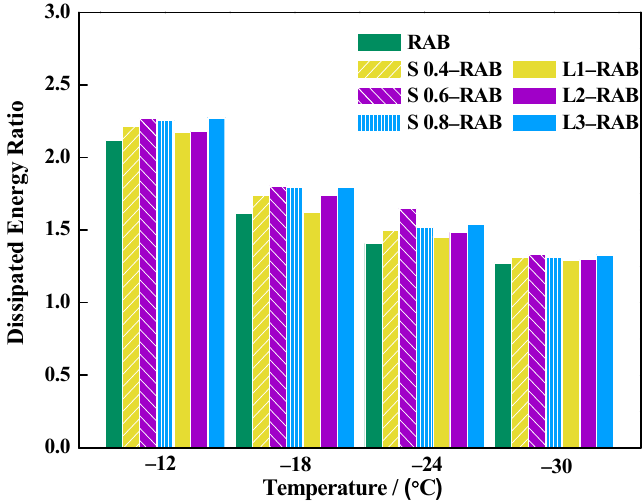
Figure 15. Results of 𝐷𝐸𝑅 based on the simple fractional